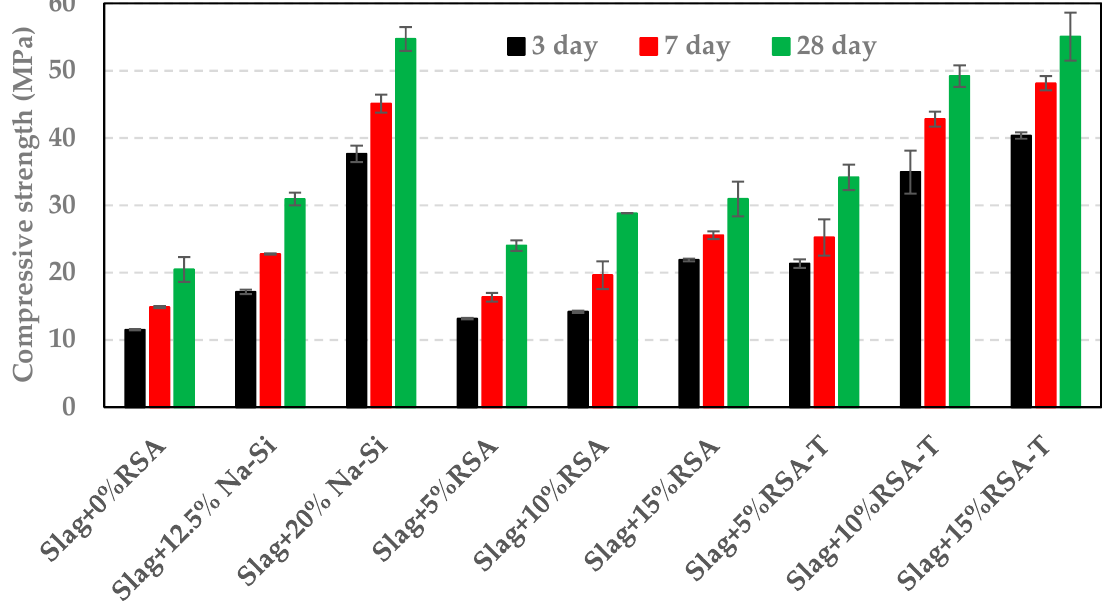
Figure 7. Comparison between RSA and sodium silicate.